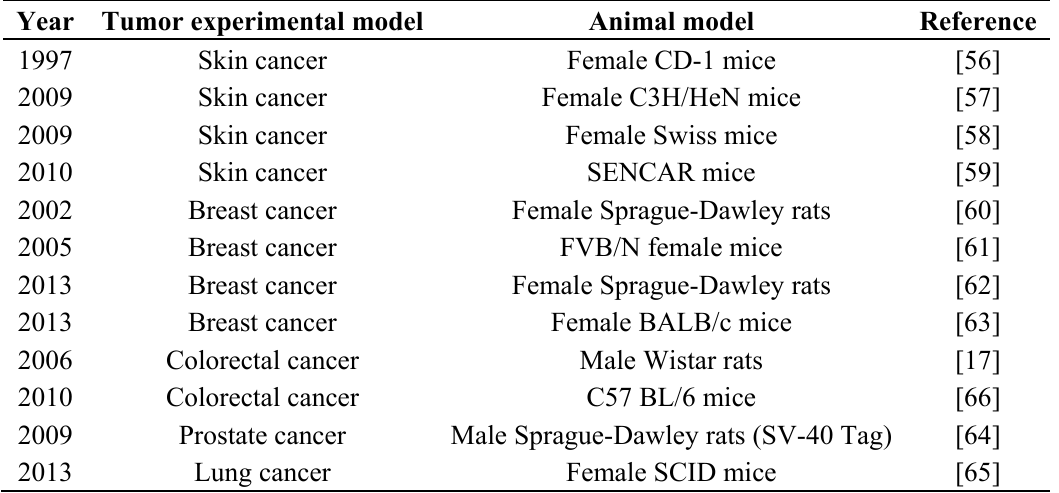
Table 1. Some of the most relevant papers describing the use of RSV on animal experimental models of solid